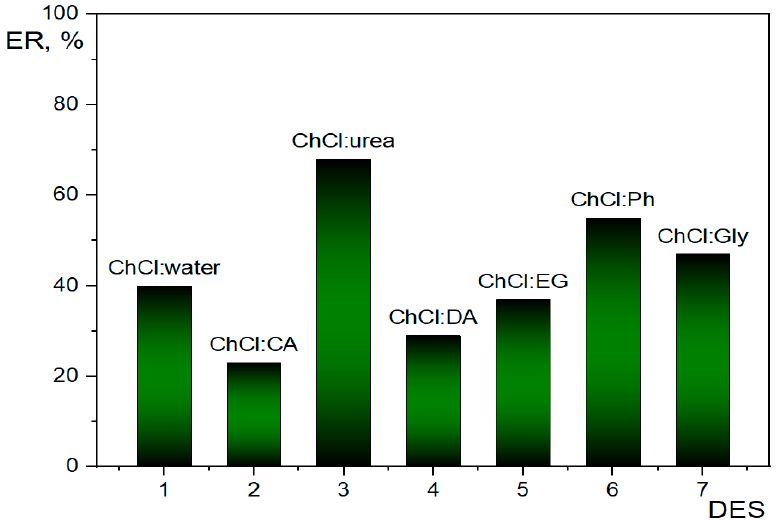
Figure 3. Extraction efficiency of different deep eutectic solvents for RP-DLLME of tryptophan from